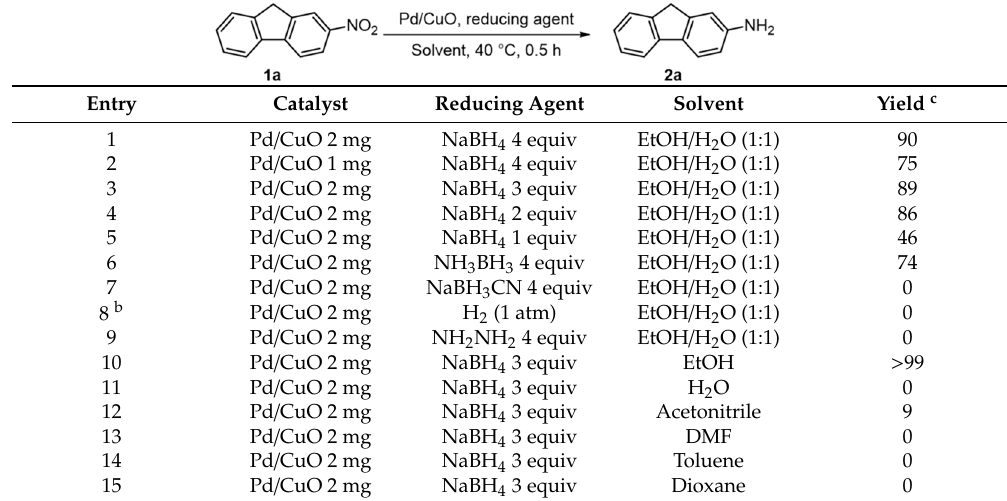
Table 1. Optimization of the nitroarene reduction a .